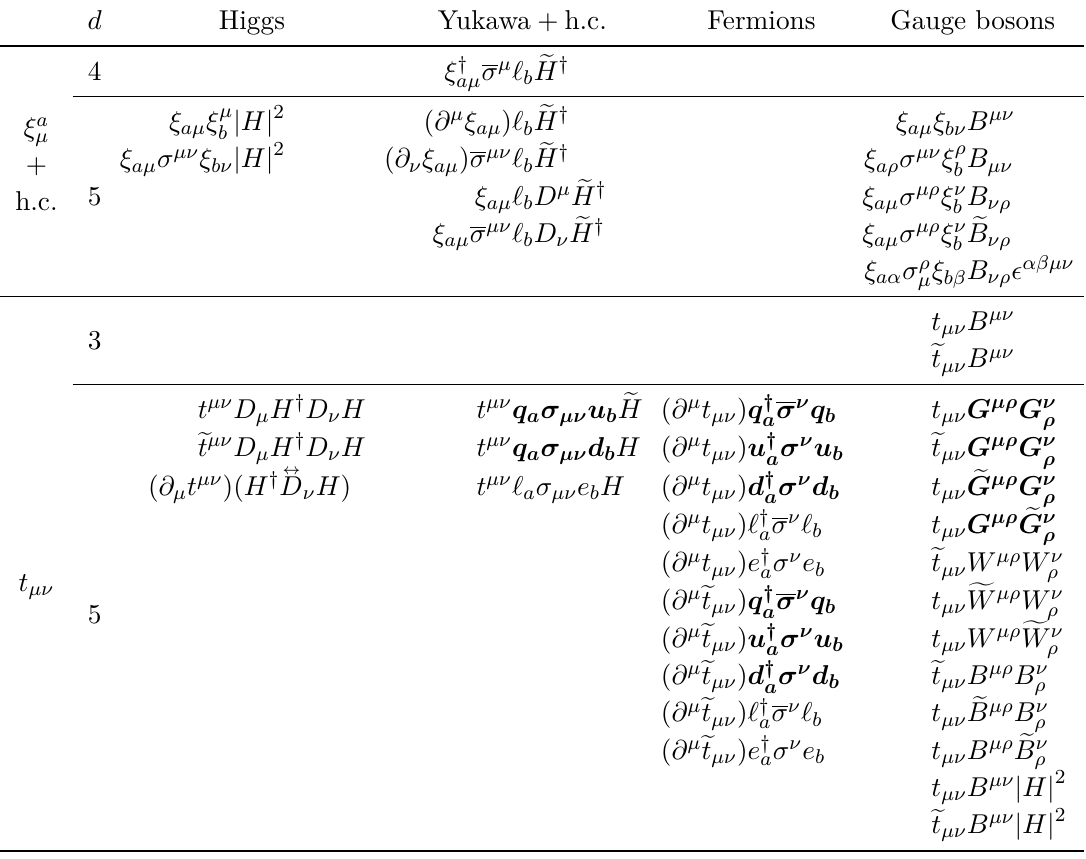
Table 12. List of all portal operators up to dimension five that couple SMEFT to hidden spin 3 fermionic fields ξ µ and tensor fields t µν . The first column specifies the type of portal, the second a column denotes the dimension d of the portal operator and the remaining columns label the SM sectors to which the hidden field couples. In the case of the vector-fermion PETs, each operator is supplemented by its Hermitian conjugate. The bold operators couple to the strong sector of the